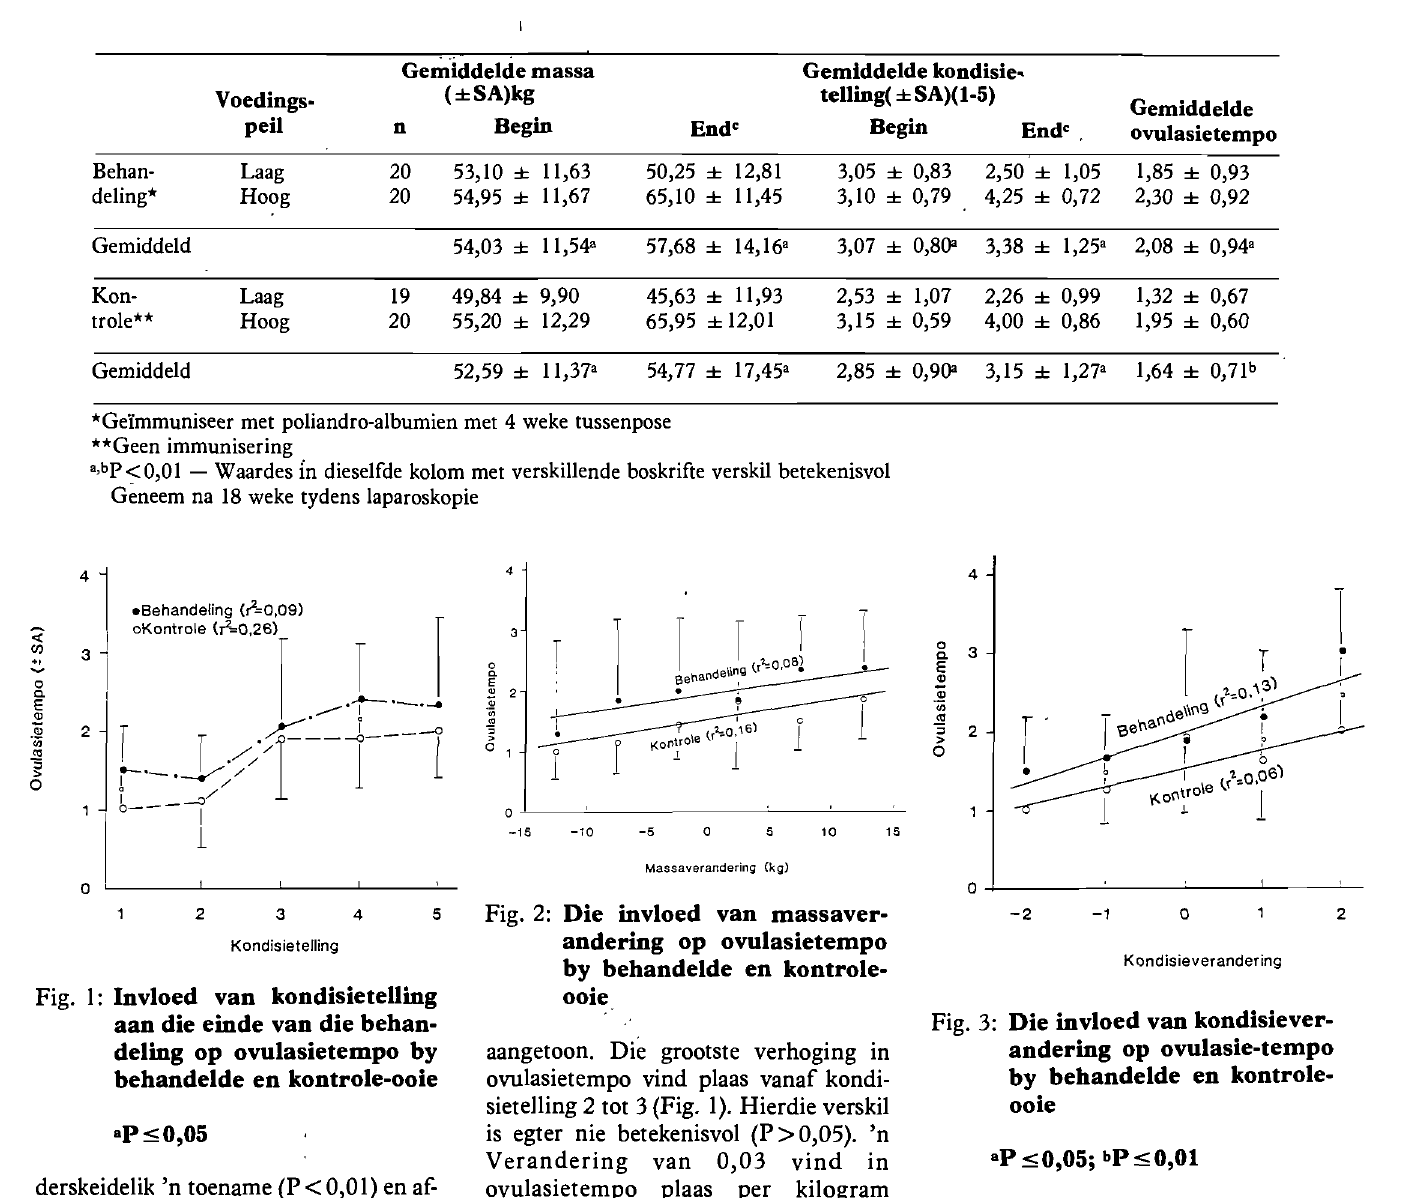
Fig. 3: Die invloed van kondisiever andering op ovulasie-tempo by behandelde en kontrole ooie